Question: Describe this figure in one sentence.
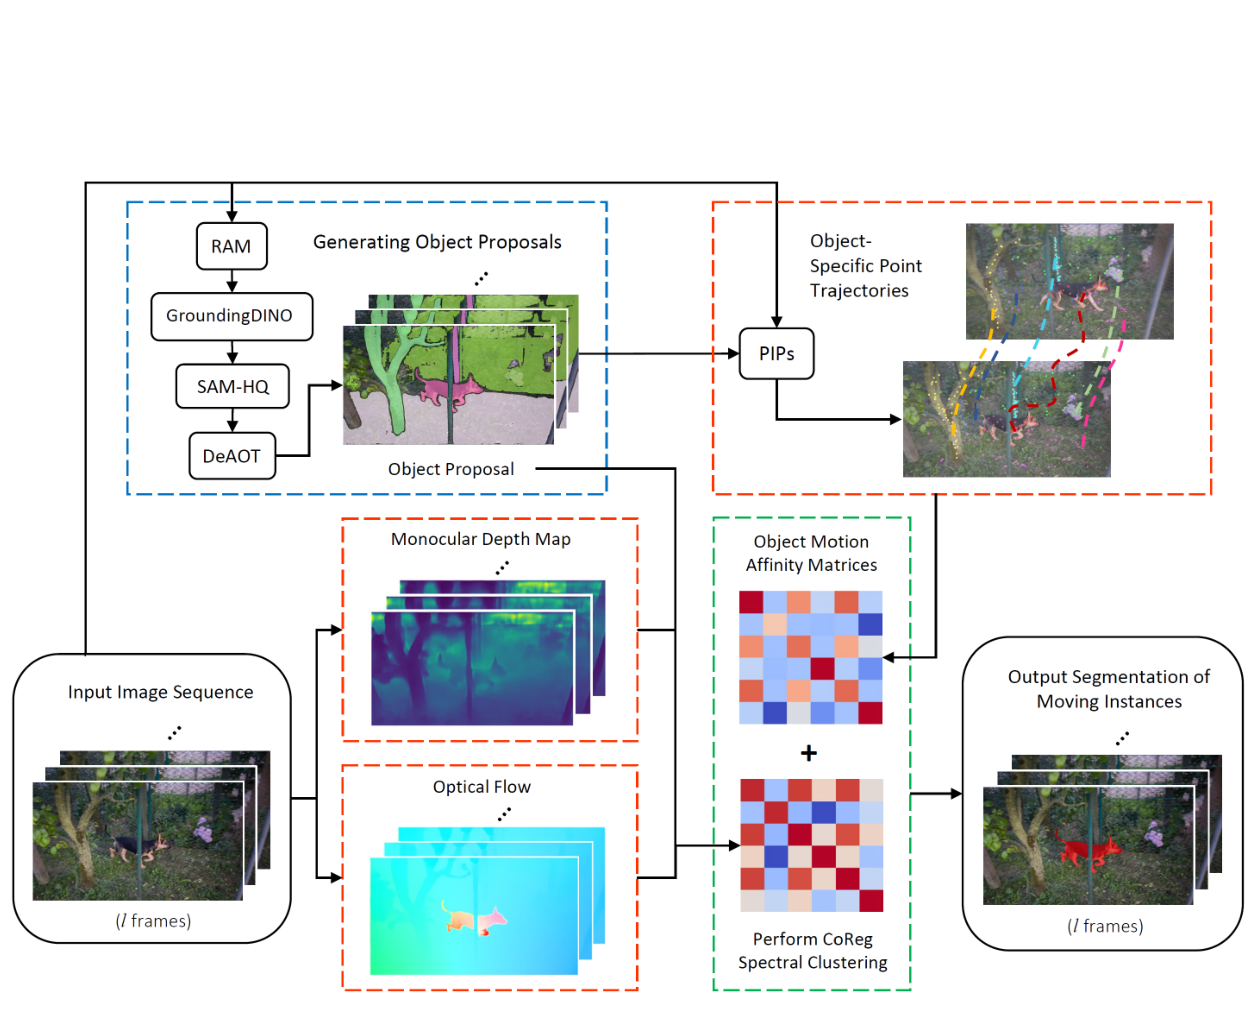
Answer: Our Motion Segmentation Pipeline. Our method can be summarized to three main steps: 1) given a sequence of video frames, we produce an object proposal by automatically detecting, segmenting and tracking common objects in the video. 2) we compute object- specific point trajectories, optical flow and monocular depth maps for every frame. 3) we compute pairwise object motion similarity scores using two motion models (one based on point trajectories and the other based on optical flow and depth map), and use them to construct two motion affinity matrices. The two matrices are fused using multi-view spectral clustering to cluster objects into different motion groups.